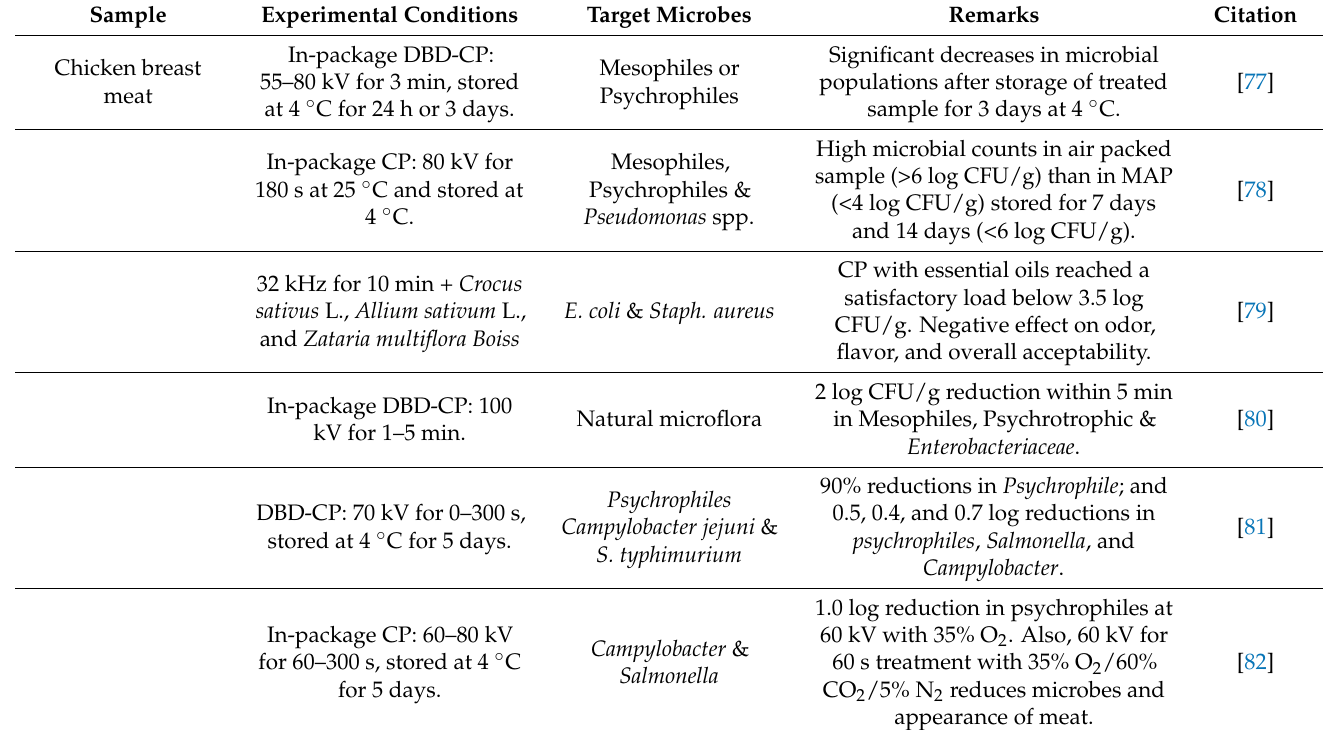
Table 3. CP applications to decontaminate meat and meat